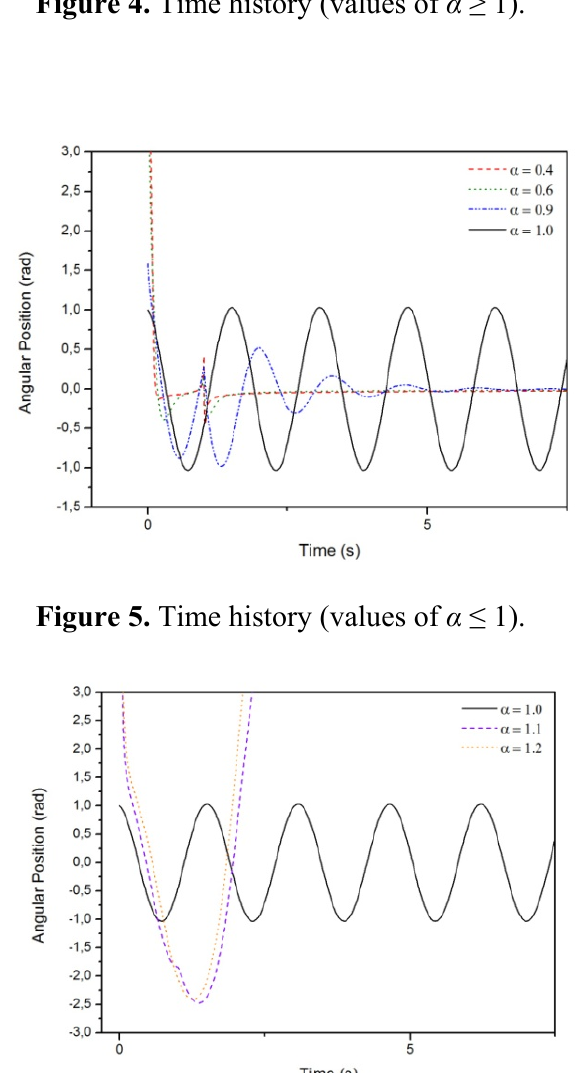
Figure 4. Time history (values of α ≥ 1).